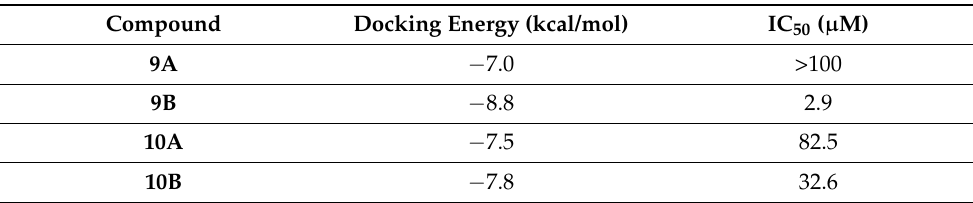
Table 2. Molecular docking energies scores and IC 50 values of compounds ( 9A , 9B , 10A , and 10B ) against hBChE. (Docking energies values for all compounds are reported in Supporting Information— 2. Molecular modelling studies Table